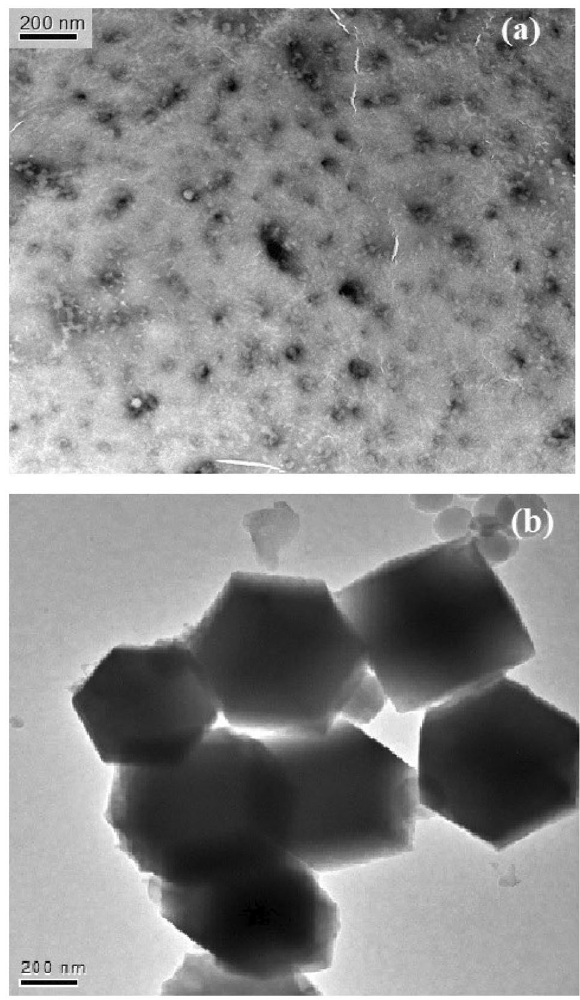
Fig. 4 TEM images of a MVPA, b : MVPA/Kaolin